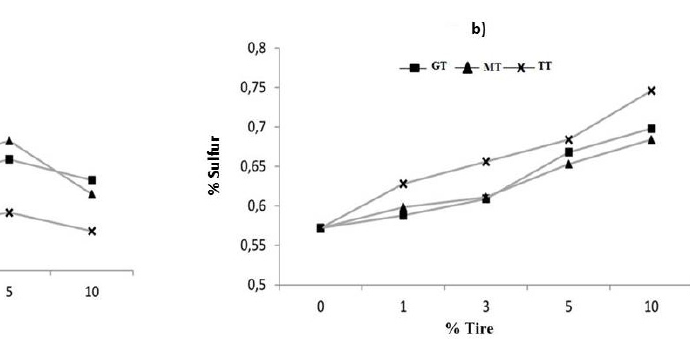
Figure 3. Analysis of ash and sulfur